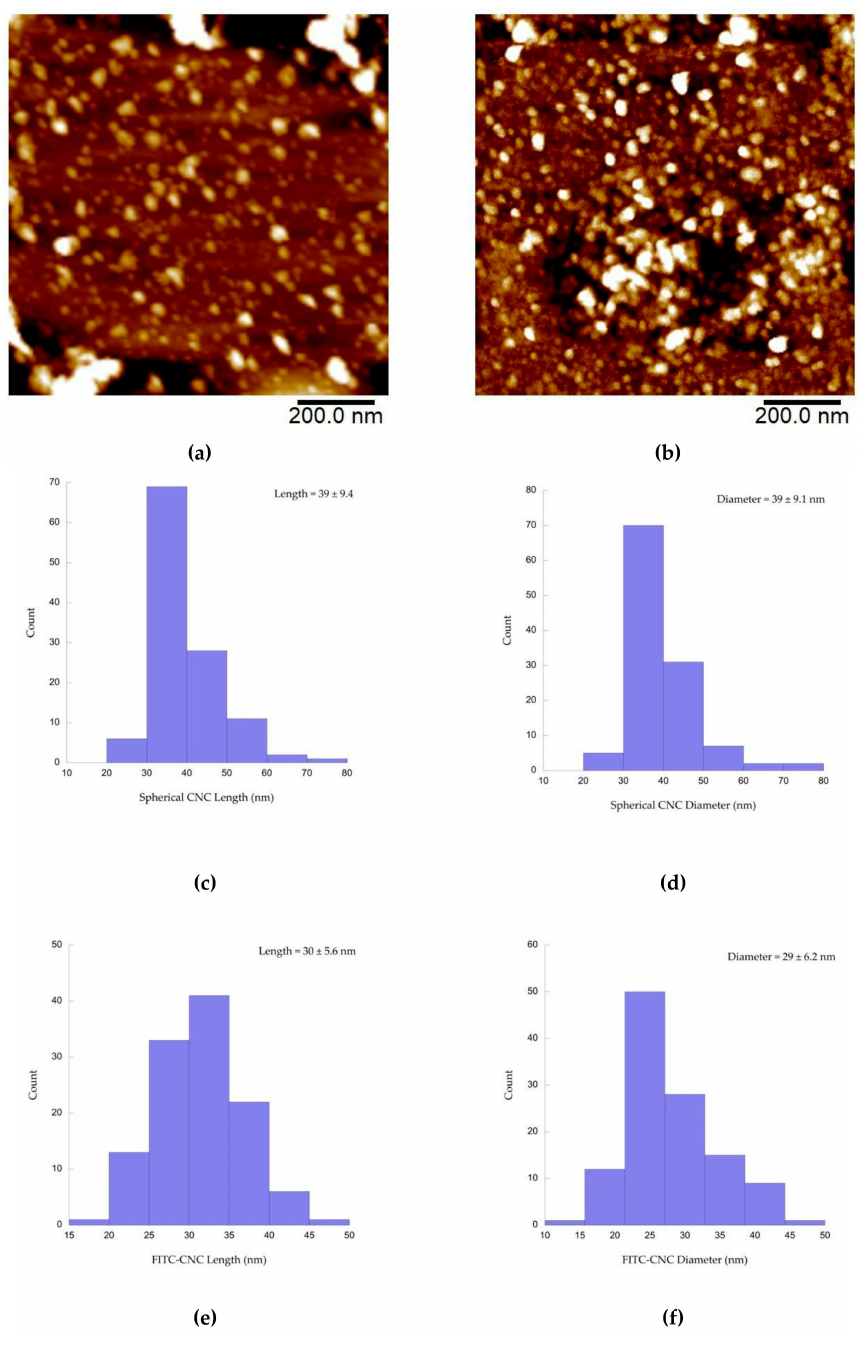
Figure 5. Atomic Force Microscopy (AFM) micrograph of ( a ) CNC and ( b ) FITC-CNC. Histogram of ( c ) spherical CNC length, ( d ) spherical CNC diameter, ( e ) spherical FITC-CNC length, and ( f ) spherical FITC-CNC diameter with their respective